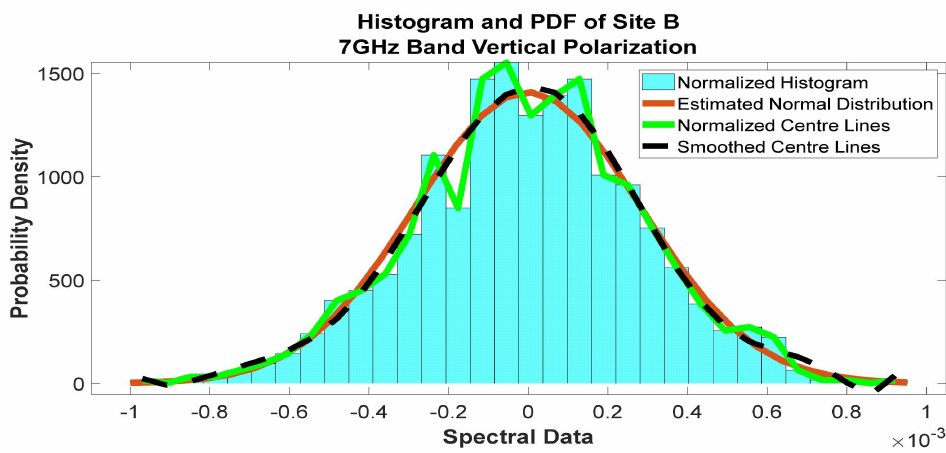
Figure 24. Histogram and PDF of the frequency scan for site B at 7 GHz vertical